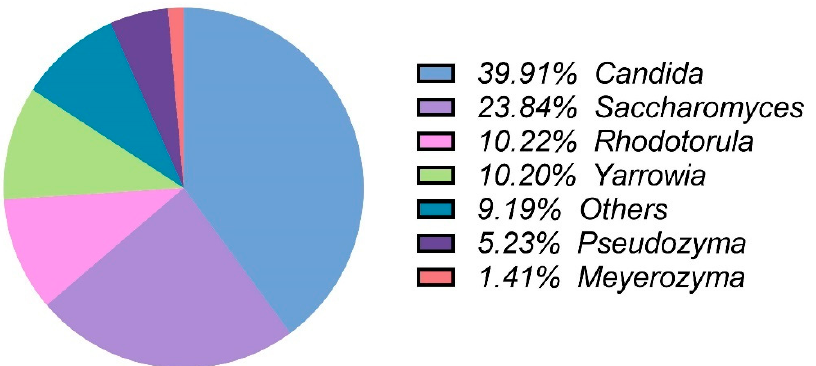
Figure 3. Publications on the main genera of BS-producing yeasts in the last 5 years. Data collected from Google Scholar searches on the number of articles published from 2018 to 2022 ( n = 9020), excluding reviews. Table 1. Yeast-producing BS using different